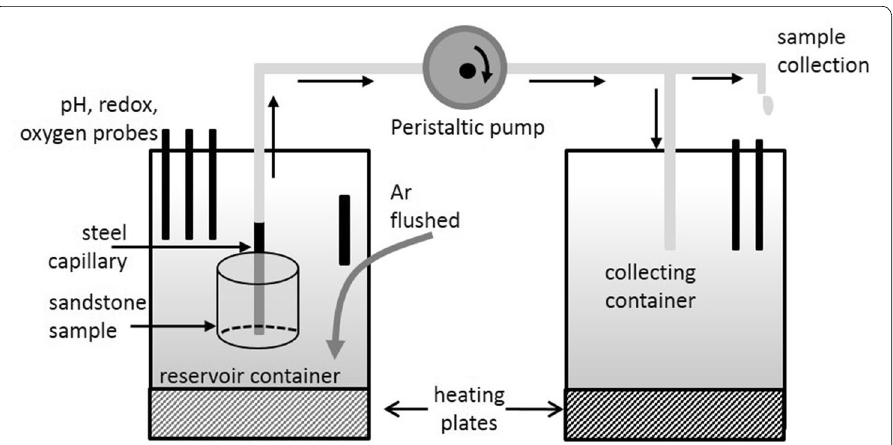
Fig. 1 Experimental set-up: Brine of different composition is pumped from the anoxic reservoir container via a peristaltic pump under anoxic conditions (Ar-purged) into the collecting container through a steel capillary that is inserted in a rock sample. After the reaction, the fluid can be sampled or collected in the collecting container (for experimental conditions see Table 1). Probes measuring pH, redox, and oxygen are installed in both containers. Temperatures can be adjusted by heating up the containers on a heating plate